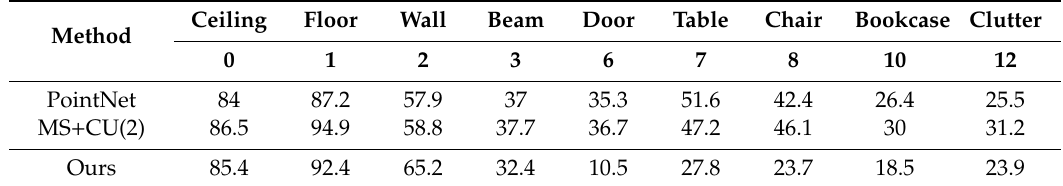
Table 10. Benchmark results of our semantic segmentation approach against deep-learning methods without any colour information used.